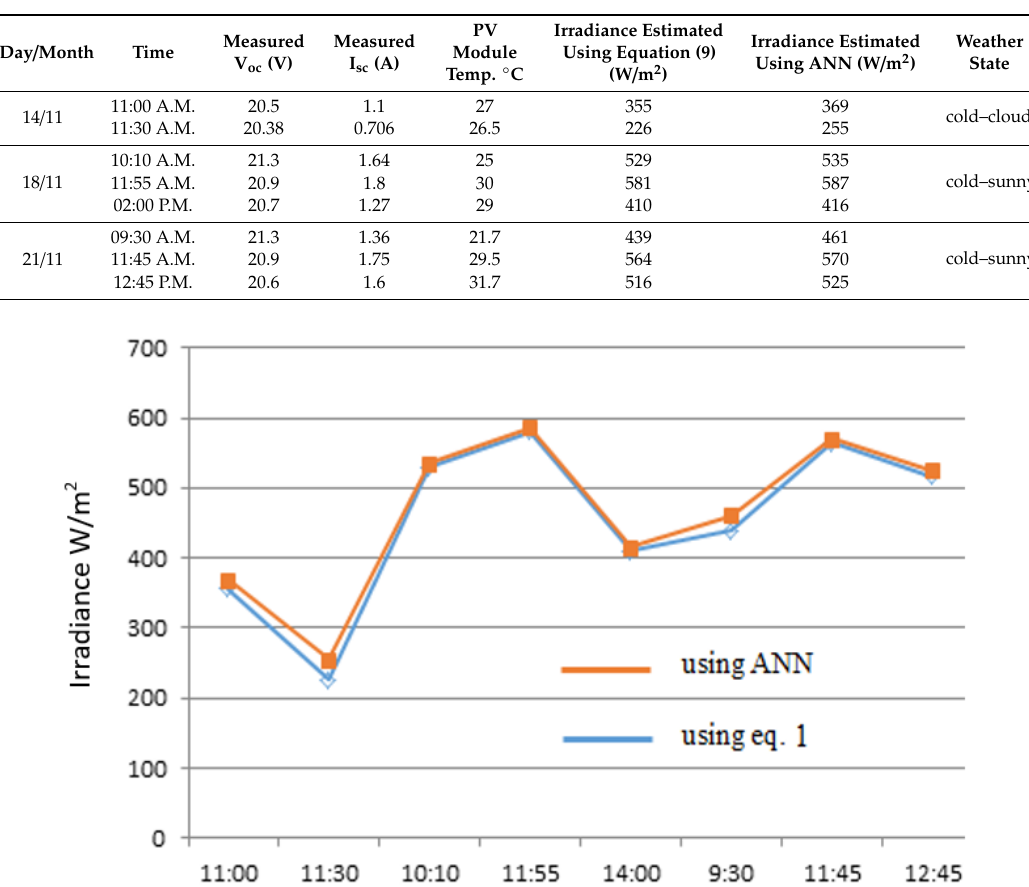
Figure 9. Comparison between irradiance estimates based on NN and Equation (1).